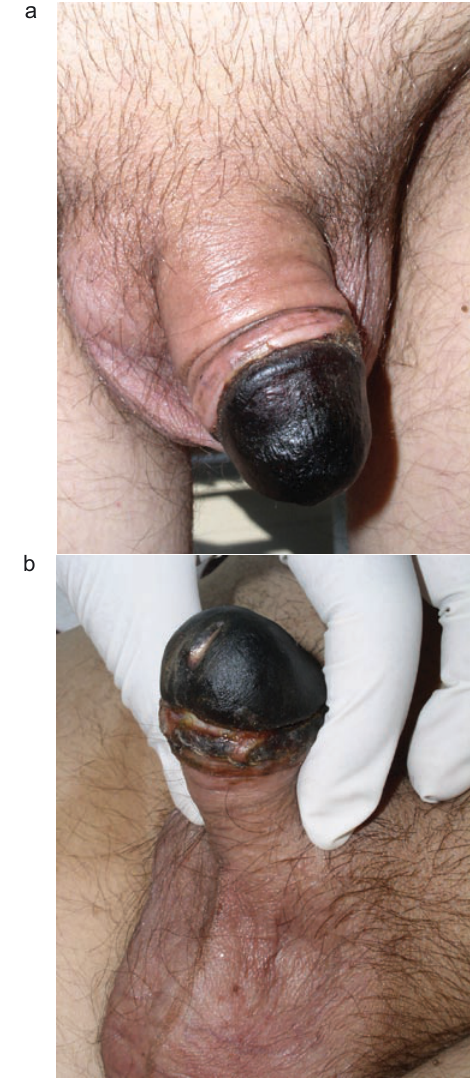
Figure 2. Penile